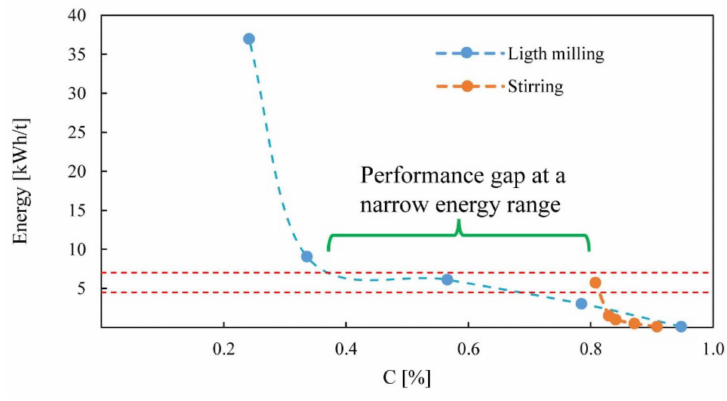
Figure 11. Overall energy consumption along time for each attrition